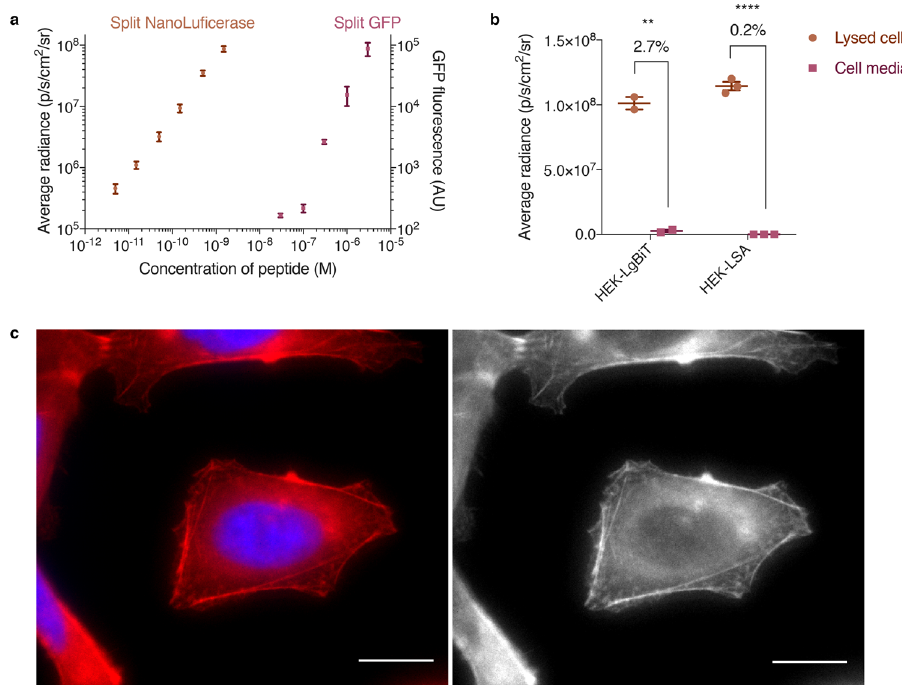
Fig. 2 SLEEQ is four orders of magnitude more sensitive than split GFP. a In a 96-well plate assay, the concentration of LgBiT and GFP 1 – 10 were fi xed at 50 and 3 µ M, respectively. LgBiT was sensitive to <5 pM of HiBiT, while GFP 1 – 10 required >0.1 µ M of GFP 11 to generate a detectable signal. b HEK293 cells with LgBiT expressed in the cytosol (HEK293-LgBiT) excreted 2.7% of the protein into the supernatant. When LgBiT was fused to cytoskeletal protein actin (HEK293-LSA), only 0.2% of the LgBiT was detected in the supernatant. Two-tailed unpaired t test was used to analyse the data. n = 2 independent experiments for HEK293-LgBiT and n = 3 independent experiments for HEK293-LSA. ** p ≤ 0.01 and **** p ≤ 0.0001. A SNAP-tag was also fused to LgBiT- actin to aid visualisation of the fusion protein. c Pseudocoloured (left) and greyscale (right) images of HEK293 cells expressing LSA (red) show cytosolic staining consistent with actin. Nucleus was stained with Hoechst 33342 (blue). n = 3 independent experiments Scale bar = 10 µ m. Source data are provided as a Source Data fi